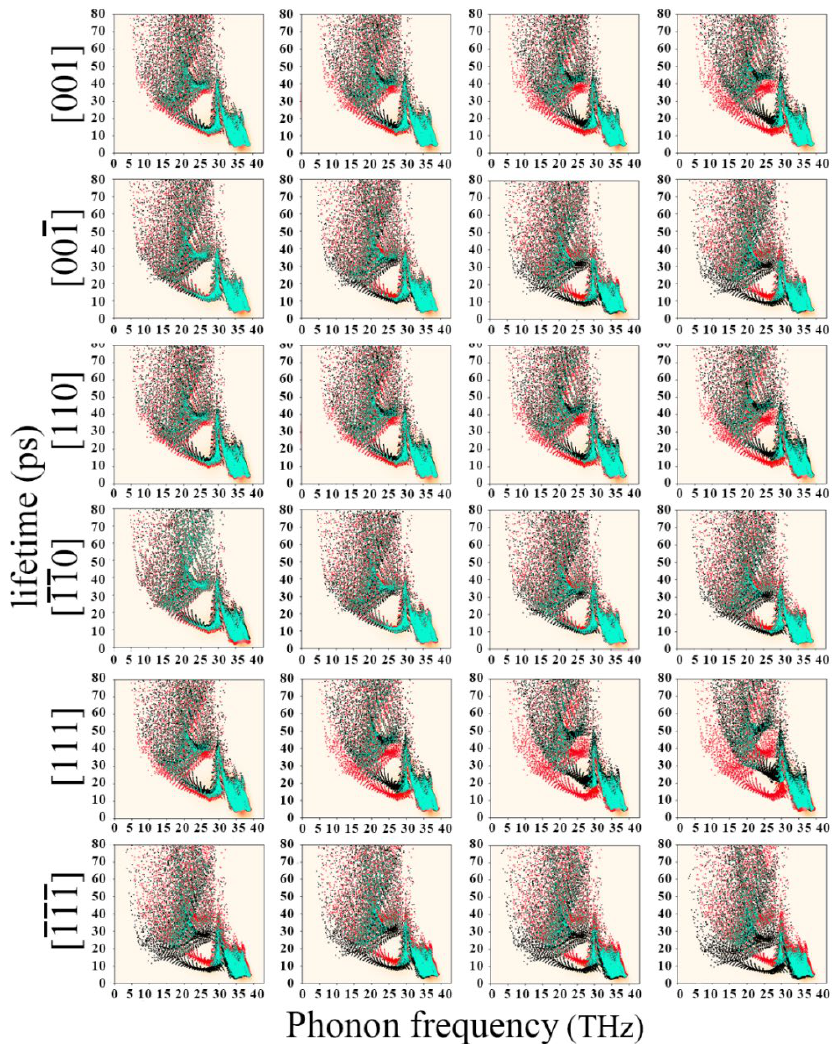
Figure 18. Plot of phonon lifetime versus frequency after the electric field is applied in the diamond's 3 crystallographic orientations.